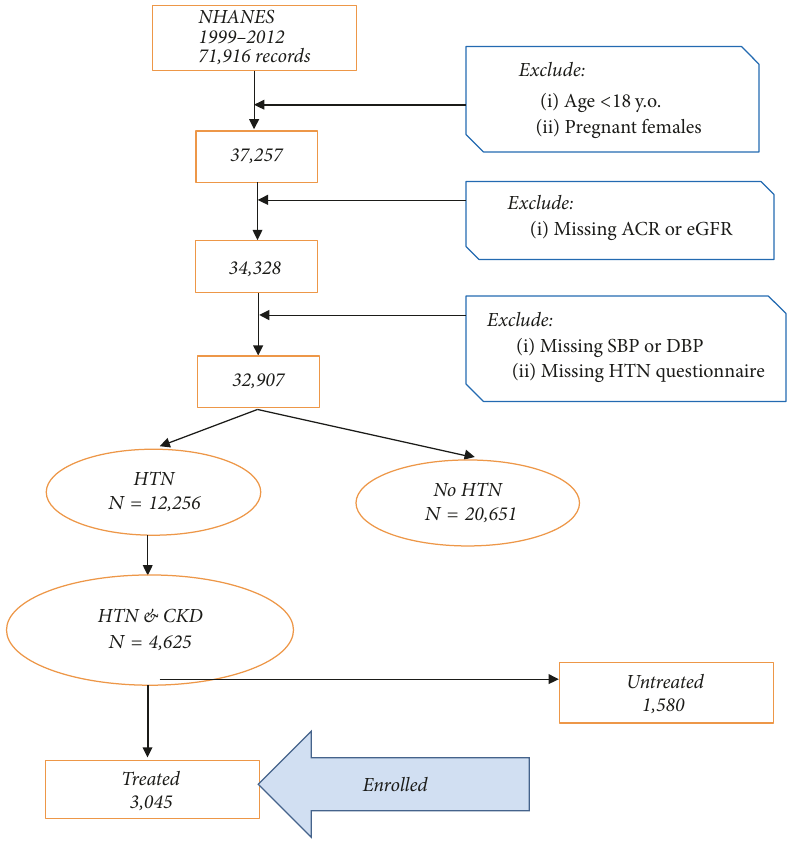
Figure 1: Consort flow